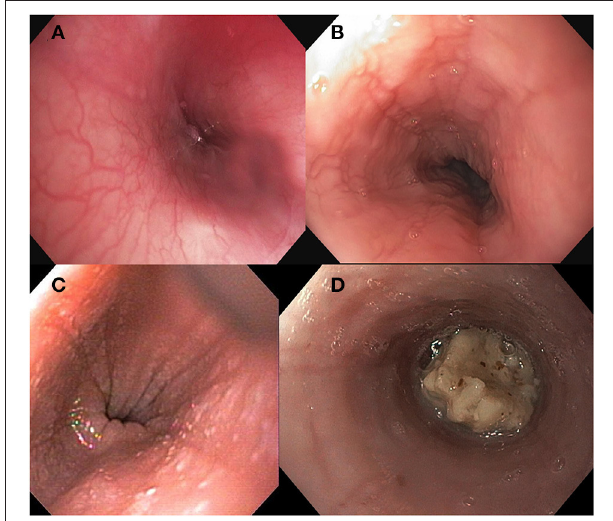
FIGURE 1 | Endoscopic findings in Eosinophilic Esophagitis including (A) normal esophageal mucosa (B) longitudinal furrows, (C) white exudate, and (D) food bolus